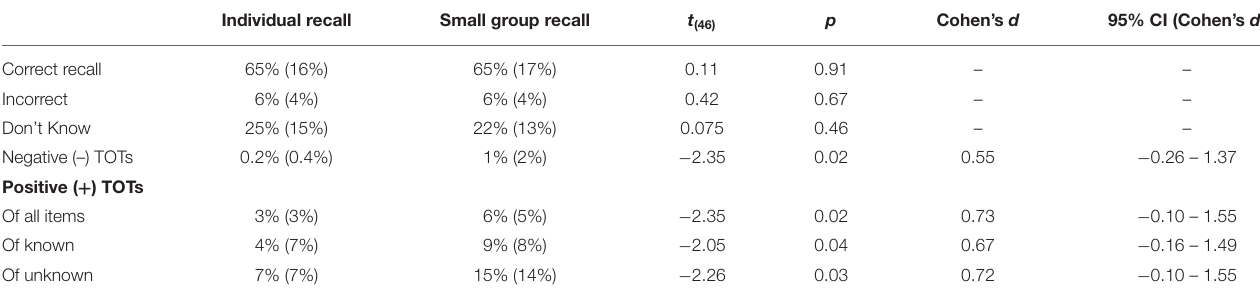
TABLE 6 | Mean (standard deviation) percentages of correctly recalled items, incorrect and “Don’t Know” responses, negative and positive TOT indexes, by recall condition, after removing trials with common TOT and/or verbal exchanges (45% of TOTs). Individual